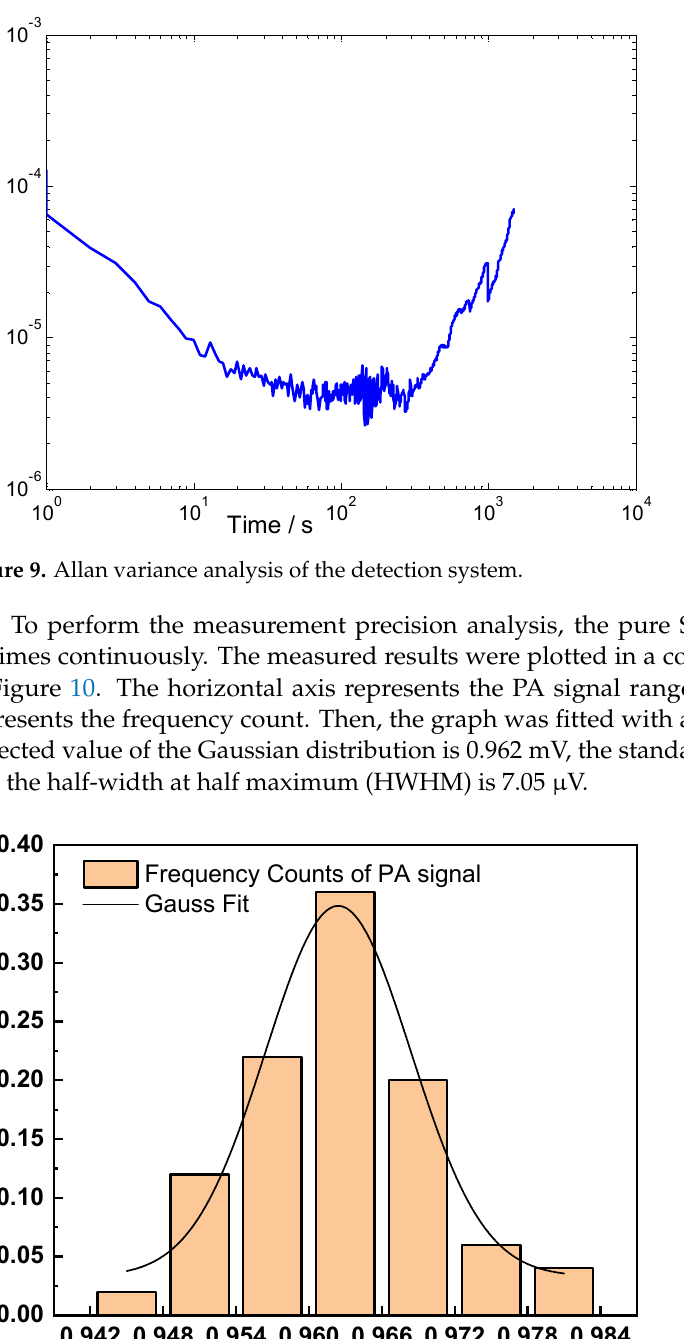
Figure 10. The horizontal axis represents the PA signal range, and the vertical axis repre- sents the frequency count. Then, the graph was fitted with a Gaussian profile. The ex- pected value of the Gaussian distribution is 0.962 mV, the standard deviation is 5.98 µV, and the half-width at half maximum (HWHM) is 7.05 µV.